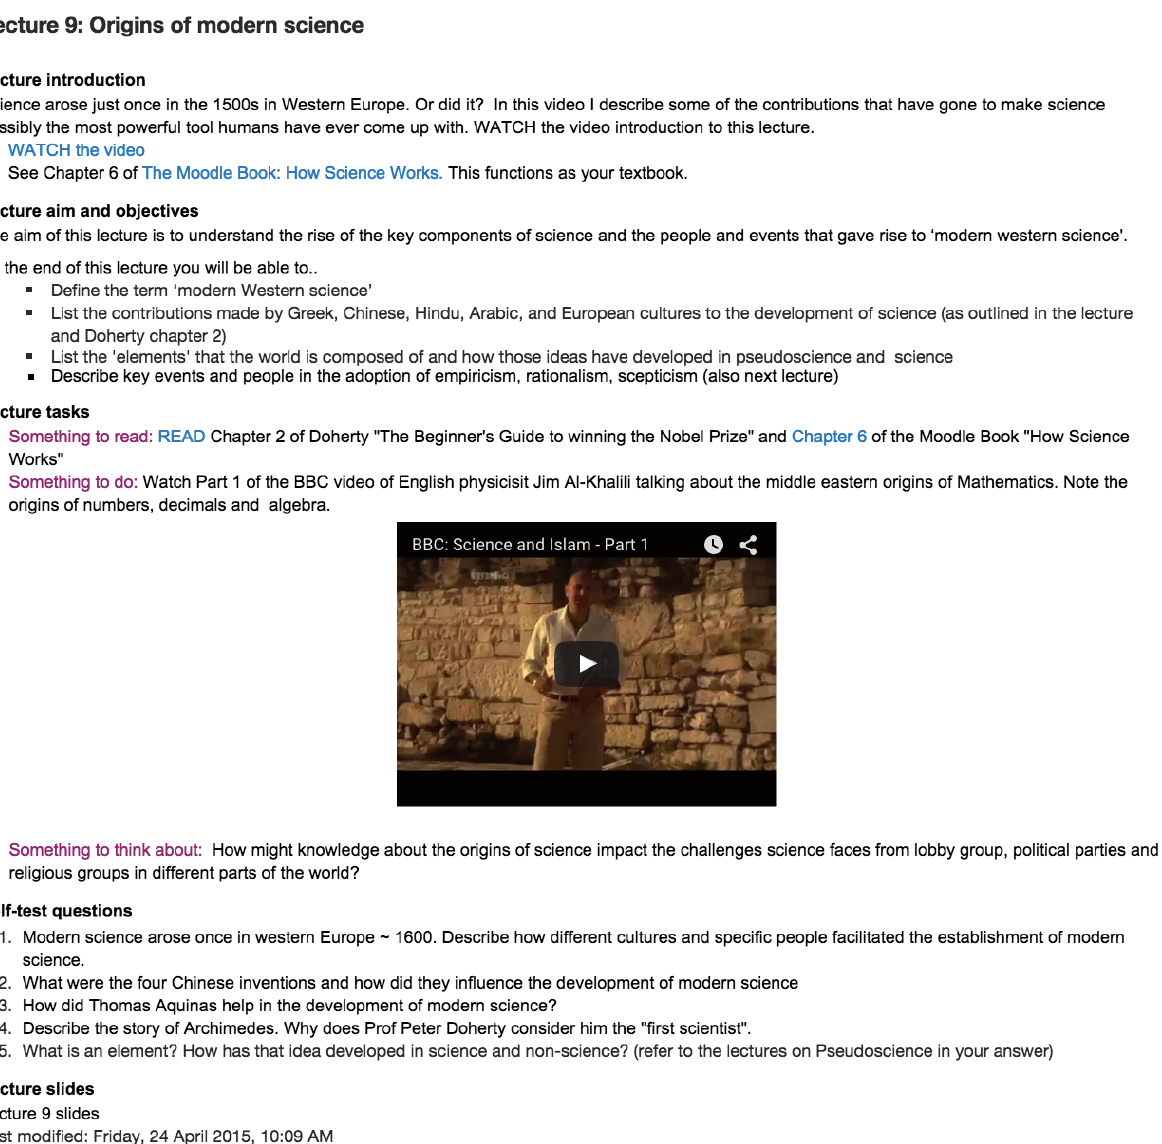
Dataset 1. Raw dataset for Gleadow et al. , 2015 ‘Design for learning – a case study of blended learning in a science unit’